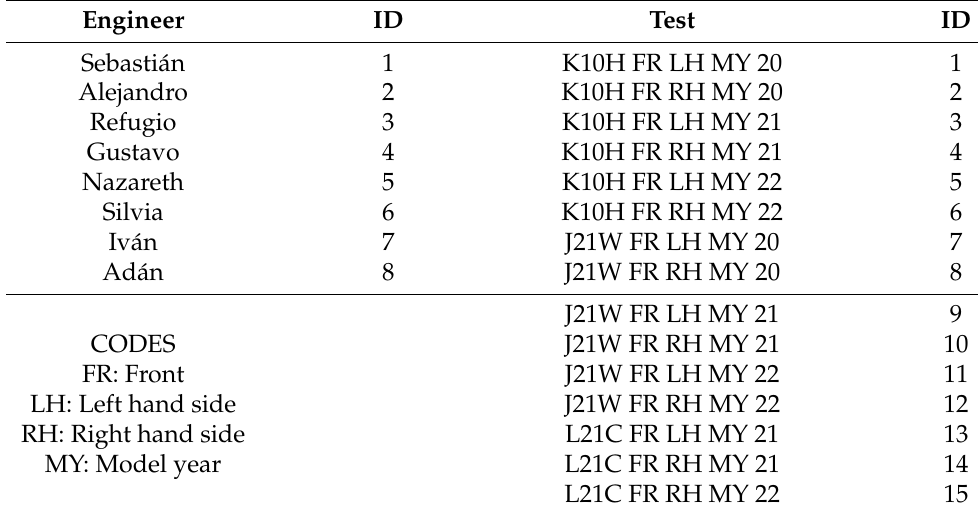
Table A2. Engineers and tests to be scheduled in jounce tester